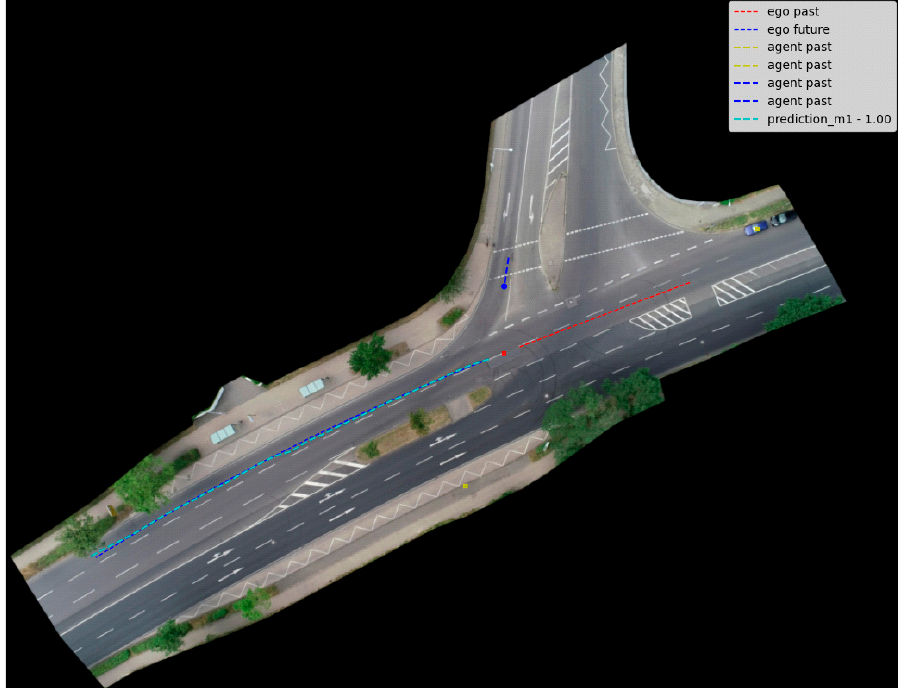
Figure 12. Traffic scene prediction with the unimodal approach. In this scenario, the car is changing the lane.